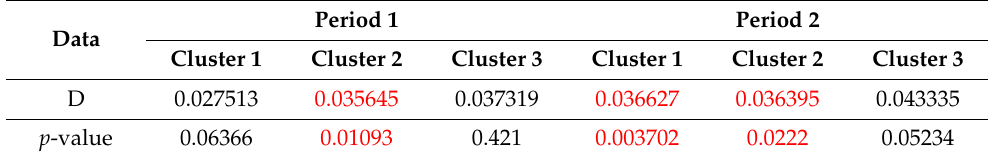
Table 16. One sample Kołmogorov–Smirnov test with an alternative hypothesis: two-sided ( α = 0.05).